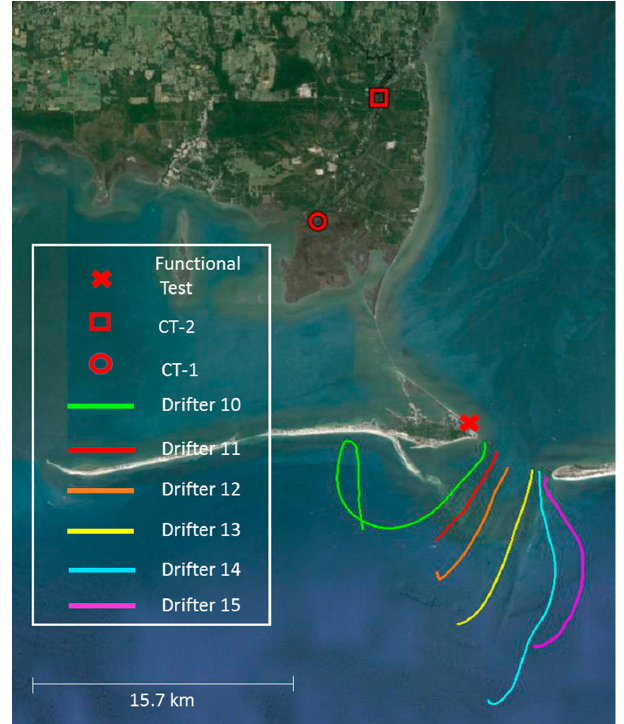
Figure 2. Plots of the recorded GPS tracks from the six drifters deployed to test the drifter application are represented by colored lines. The location of the functional testing is marked with a red X. The red square and circle identify the locations of the moored application deployments.